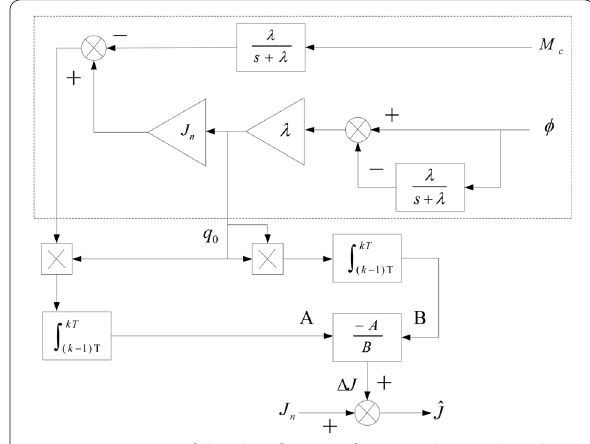
Figure 2 Diagram of the identification of rotational inertia based